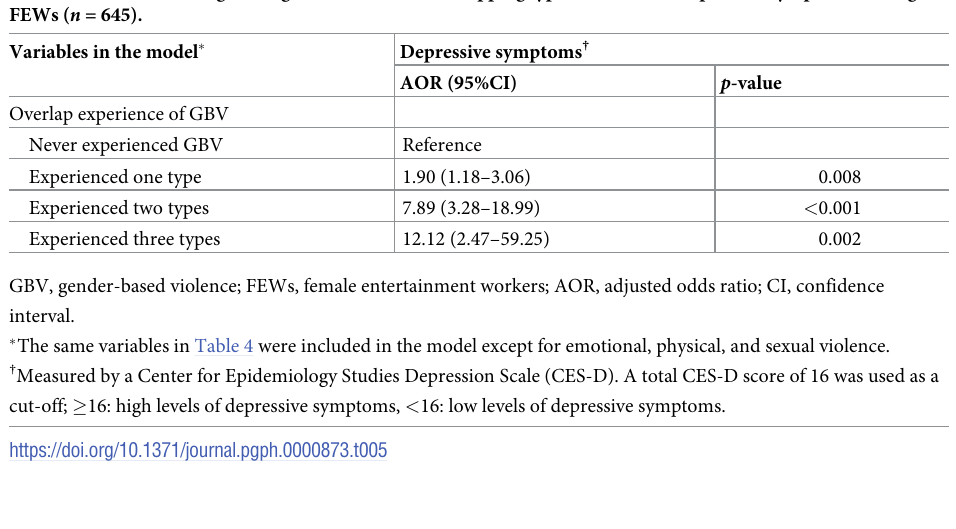
Table 5. Multivariable logistic regression between overlapping types of GBV and depressive symptoms among FEWs ( n = 645). Variables in the model � Depressive symptoms † AOR (95%CI) Overlap experience of GBV